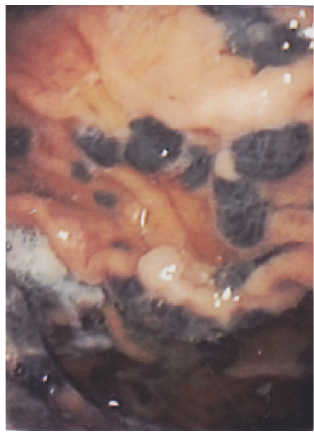
Figure 1: Presence of several medium size melanotic lesions in the fundus and the body of the stomach.